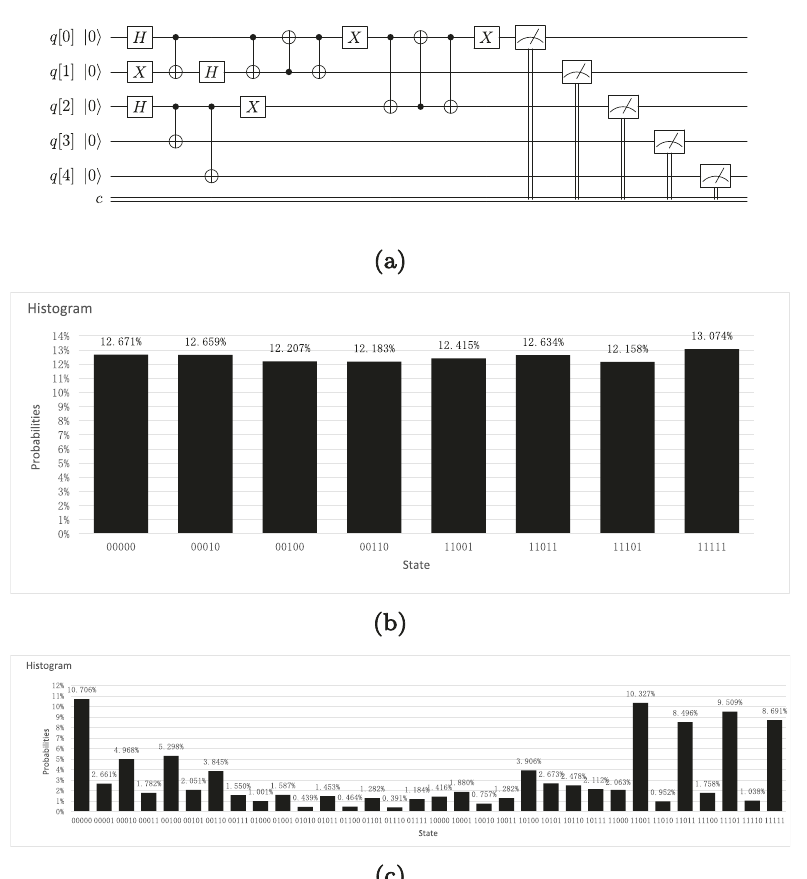
Fig. 4 The experimental demonstration of generating GHZ state. a Quantum circuit for generating three-qubit GHZ state between three parties that are not related at fi rst. b The simulation results of quantum circuit after fi ve measurements in Z-basis. c The probability results of quantum circuit on ibmqx2